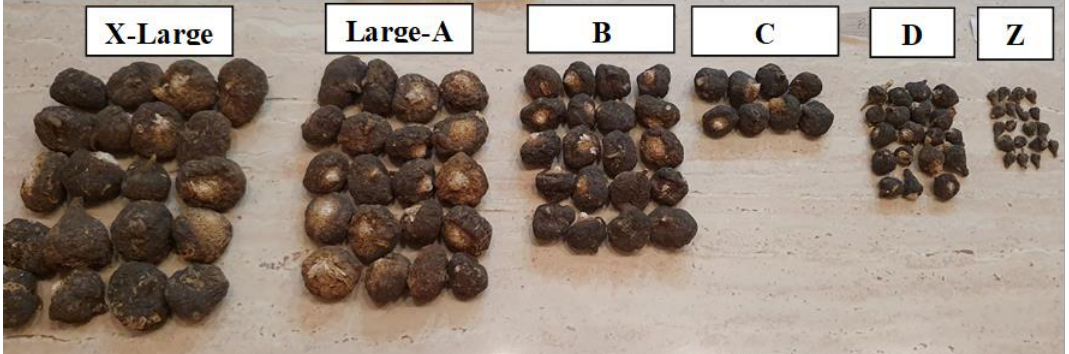
Figure 8. An example of distribution of black maca tubers allocated to size classes dependent on physical size and weight in the black phenotype of L. peruvianum synon. L. meyenii). All L. peruvianum extracts used in the study were obtained with 50% aqueous ethanol [37] ( v / v ) by ultrasound-assisted extraction technique. Three extraction cycles of 30 min each were performed on 2 g of the same plant material using fresh portions of extracting solvent at room temperature. The selected solvent to solid ratio was 1:1 ( v/v ). After extrac- tion, the extracts were joined and evaporated to dryness using a vacuum evaporator at 50 °C. The obtained residue was weighed and stored in a refrigerator at 5 °C until the analy- sis. Juice samples were produced by cutting fresh bulbs of L. peruvianum and placing them into a slow juicer. The collected samples were later centrifuged, filtered through a syringe filter (nominal pore size of 0.2 µm), and used for chromatographic analysis .